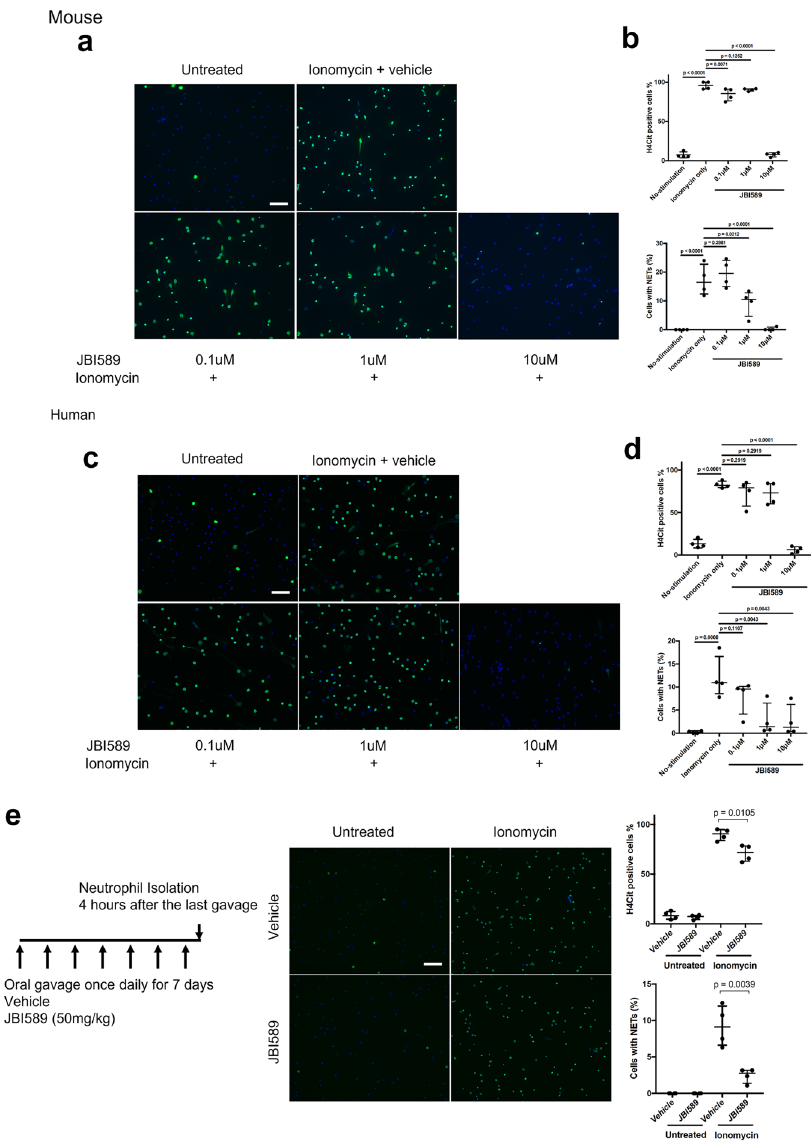
Figure 2. Inhibitory effects on citrullinated histone H4 and NET formation in vitro. ( a ) Mouse neutrophils with NET formation stained with citrullinated histone H4 (H4Cit) by Immunofluorescent microscopy. Isolated neutrophils from mouse peripheral blood were incubated with JBI-589 (0, 0.1, 1 and 10 µM) for 20 min followed by addition of ionomycin (4 µM) for 4 h (blue: Hoechst 33,342 (DNA), green: H4Cit antibody stain, scale bar = 100 μm). Representative of n = 4 experiments. ( b ) Quantifications of H4Cit positive cells (upper panel) and cells with NET formation (lower panel) by counting at least 200 cells per sample. ( c ) Human neutrophils with NET formation stained with citrullinated histone H4 (H4Cit) and visualized by immunofluorescent microscopy. Isolated neutrophils from mouse peripheral blood were incubated with JBI-589 (0, 0.1, 1 and 10 µM) for 20 min followed by addition of ionomycin (4 µM) for 4 h (blue: Hoechst 33,342 (DNA), green: H4Cit antibody stain, scale bar = 100 μm). Representative of n = 4 experiments. ( d ) Quantifications of H4Cit positive cells (upper panel) and cells with NET formation (lower panel) by counting at least 200 cells per sample. ( e ) Vehicle (water) or 50 mg/kg of JBI-589 was orally administered once daily for seven consecutive days (Left panel). Four hours after the last administration, mouse neutrophils were isolated and then a NET formation assay was performed with and without ionomycin (4 µM) in vitro. Representative images of H4Cit positive cells and cells with NET formation of n = 4 experiments (Middle). Quantifications of H4Cit positive cells (upper panel) and cells with NET formation (lower panel) was done using ImageJ and at least 200 cells were counted for each condition. The percentage of H4Cit positive cells was 88% and 83%, for vehicle and JBI-589 ( p = 0.01) treated groups,